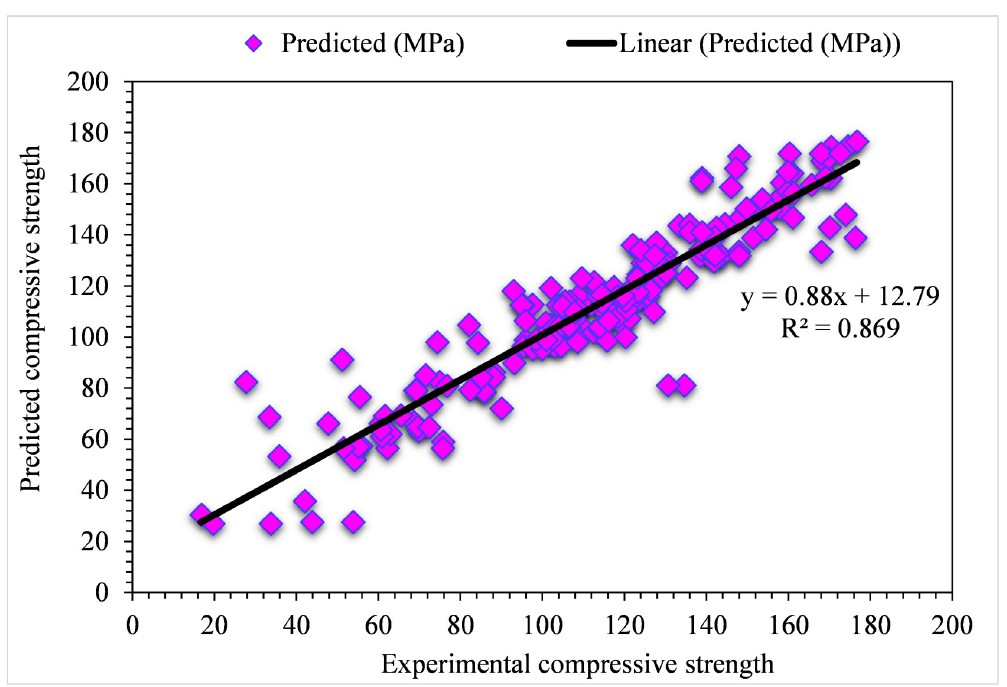
Fig 6. DT predicted and experimental values—UHPC compressive strength.